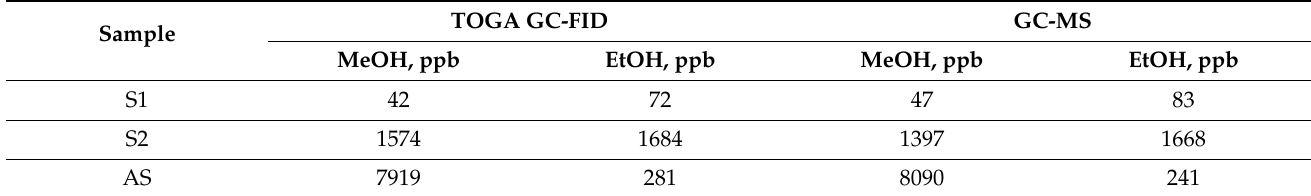
Table 3. Comparison of TOGA GC-FID with GC-MS method.